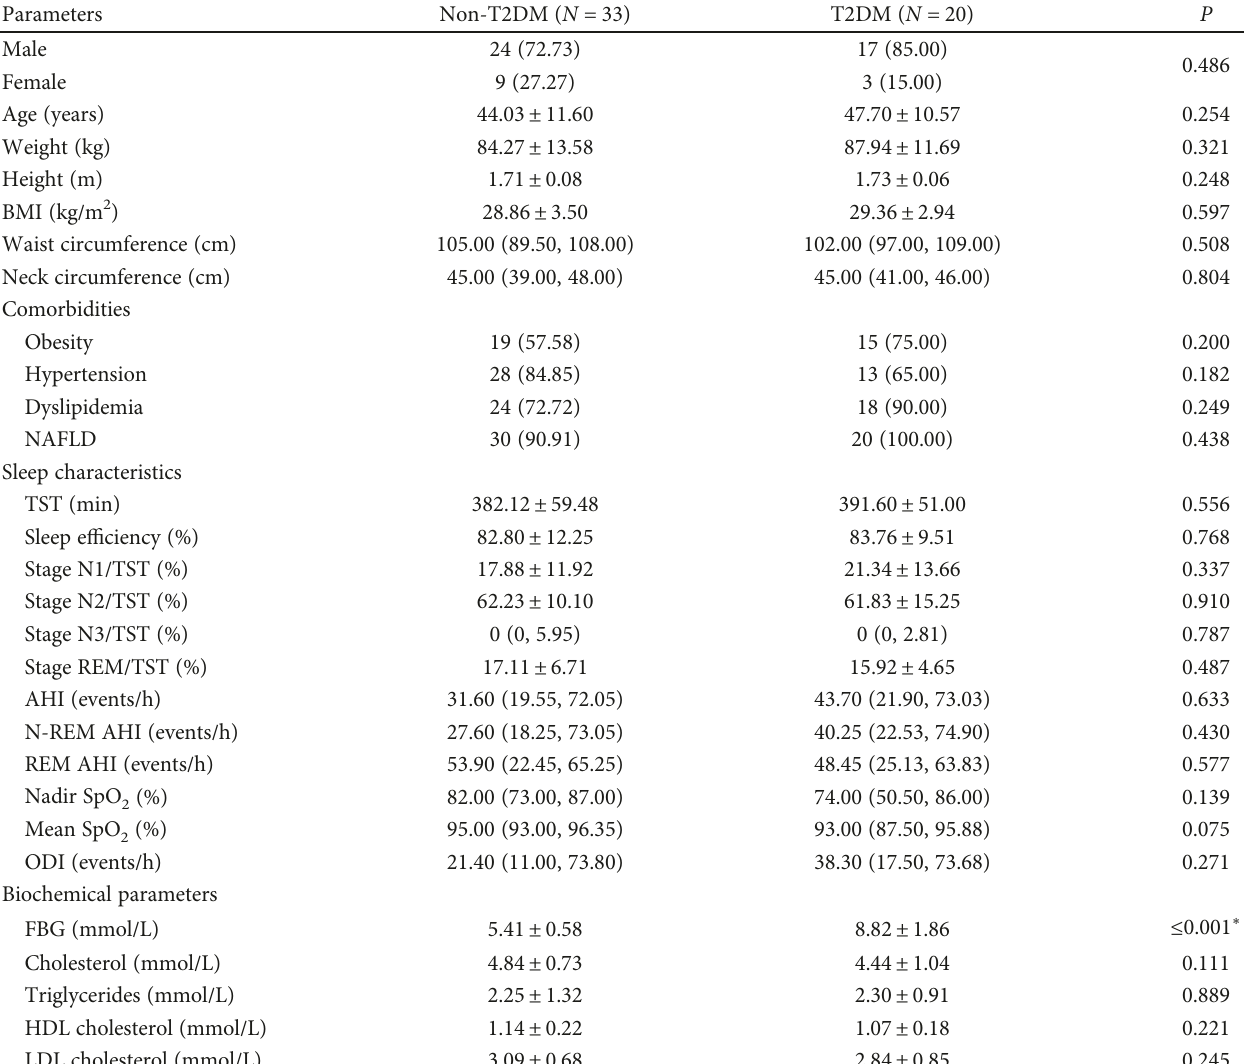
Table 1: Characteristics of OSA with non-T2DM and OSA with